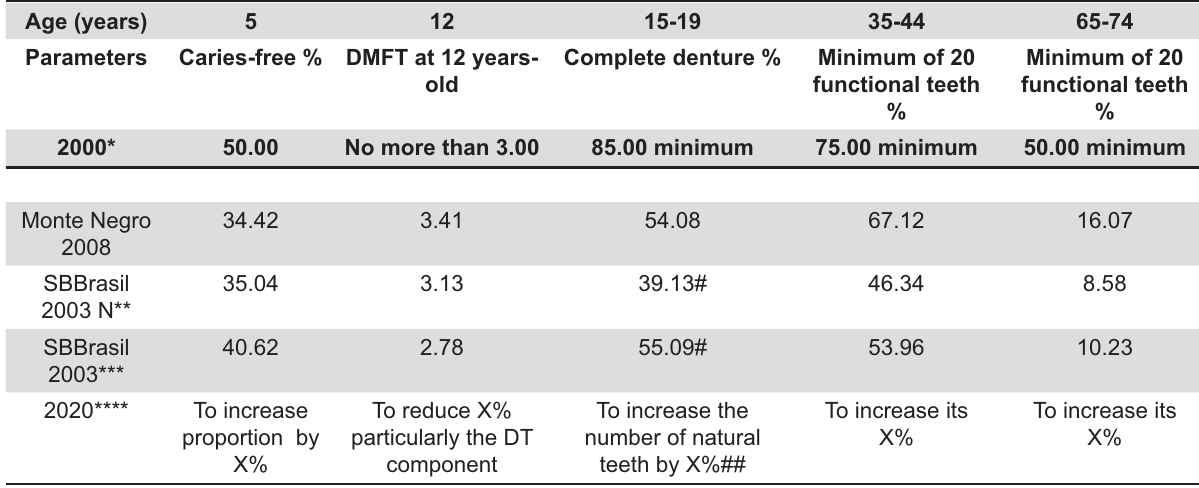
*SiC Index = means one third % higher DMFT **Care index = (FT/DMFT) x 100, DMFT>0 Table 3- Global goals for oral health in the years 2000 and 2020 related to the results of oral health survey in Monte Negro, Rondônia (2008) and Brazil